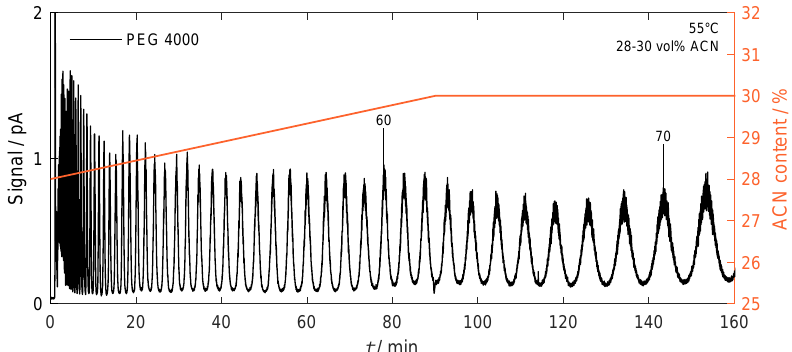
Figure 13. Example for the separation of PEG 4000 by gradient chromatography on the preparative column. Baseline resolution up to at least n = 70 is achieved. Conditions: Linear gradient from 28 to 30 vol% ACN in 90 min, followed by isocratic elution with 30 vol% ACN; 55 ◦ C; sample 50 µ L of 200 g/L pEG 4000 in